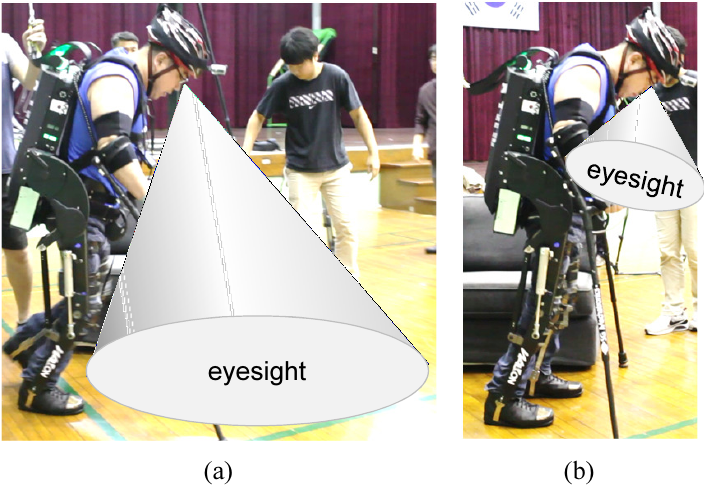
Figure 3. Postures and the associated eyesight of a complete paraplegic wearing the WalkON Suit; eyesight during ( a ) walking and ( b ) changing the mode.